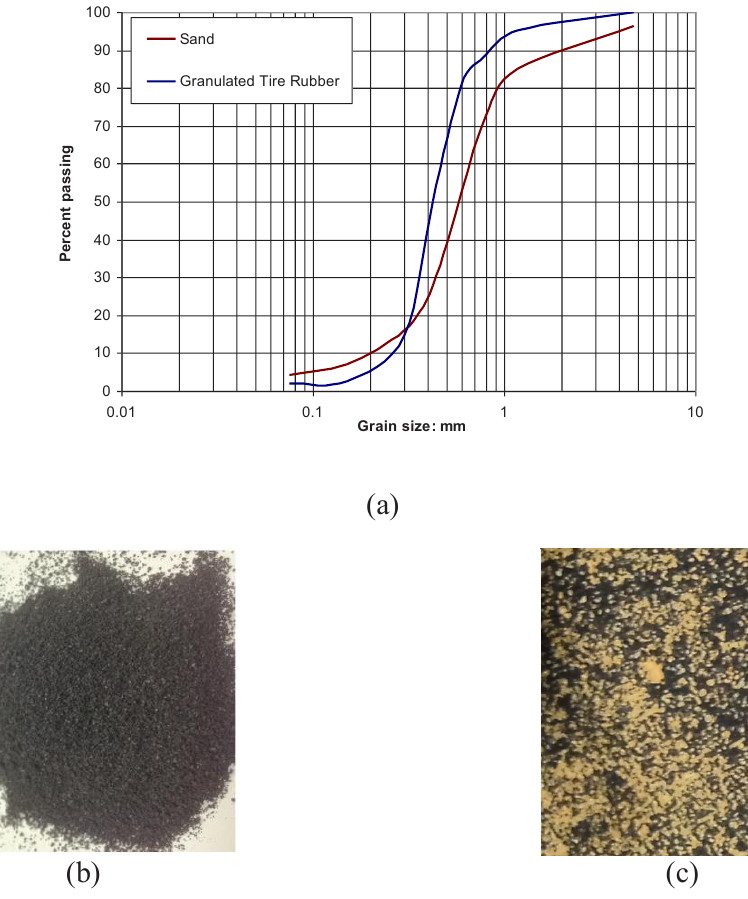
Fig. 1. (a) Grain size distribution curves of the used sand and granulated tire rubber, (b) Scrap tire rubber and (c) Sand-tire rubber mixture